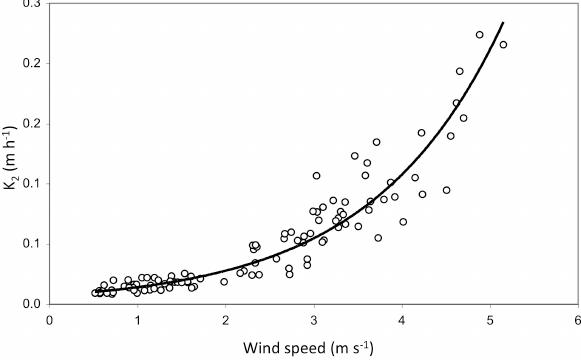
Fig. 2. The re-aeration coefficient for oxygen exchange between atmosphere and water as a function of wind